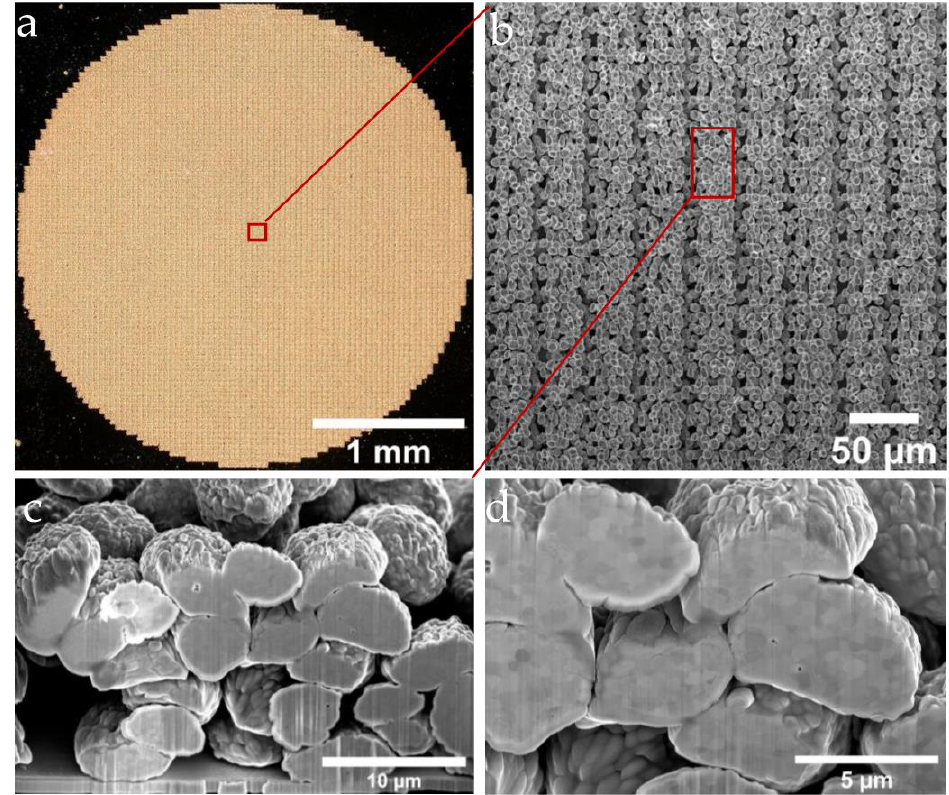
Figure 8. Microscope and SEM micrographs of the porous Au pattern with 30 µm in thickness with the hexagonal three-layer printing strategy (the experimental parameters: wavelength of 1030 nm, with z-height of 220 µm, a donor thickness of 300 nm and a 900 nm sputtered Au film as the contact layer on top of a receiver glass substrate). ( a ) Illustration of the surface morphology of the circular electrode. ( b ) A further enlarged image showing the morphology of each printed segment. The FIB milling area is shown in red. ( c ) Zoomed-in cross-sectional image showing the surface and cross-sectional details of the voxels. ( d ) A 52° tilted cross-sectional image of a 3D electrode after polishing with the FIB.